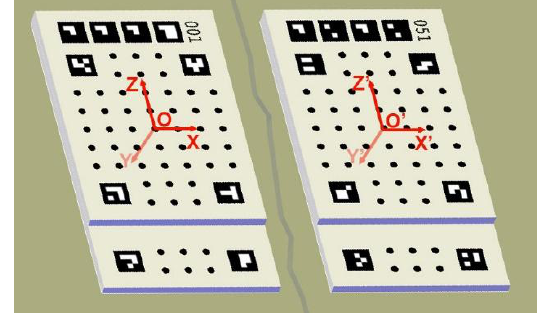
Figure 6. The coordinate systems of the blocks of photogrammetric deformation marks